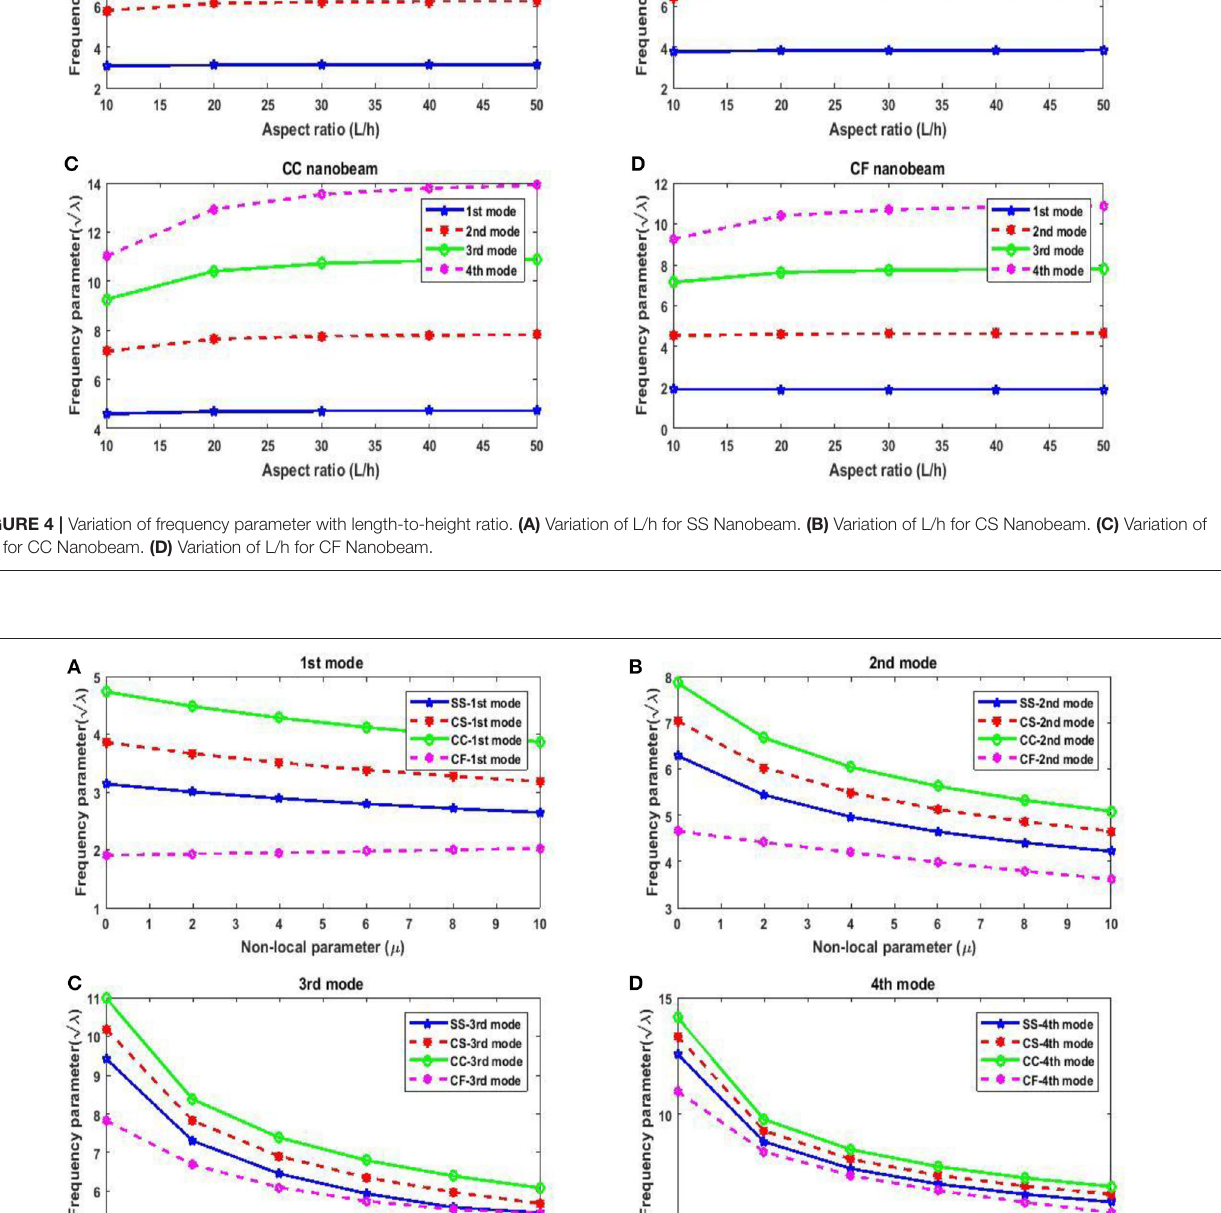
Frontiers in Built Environment |